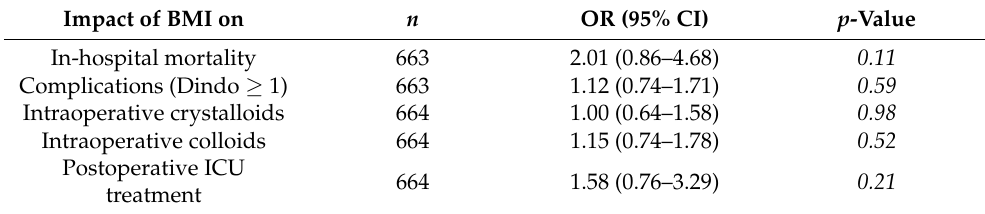
Table 5. Impact of BMI on different outcome parameters. Results of the logistic and linear regression analysis. All regression models were adjusted for ASA grade, sex, age, CCI, type of fracture. OD, odds ratio; CI, confidence interval; ICU, intensive care